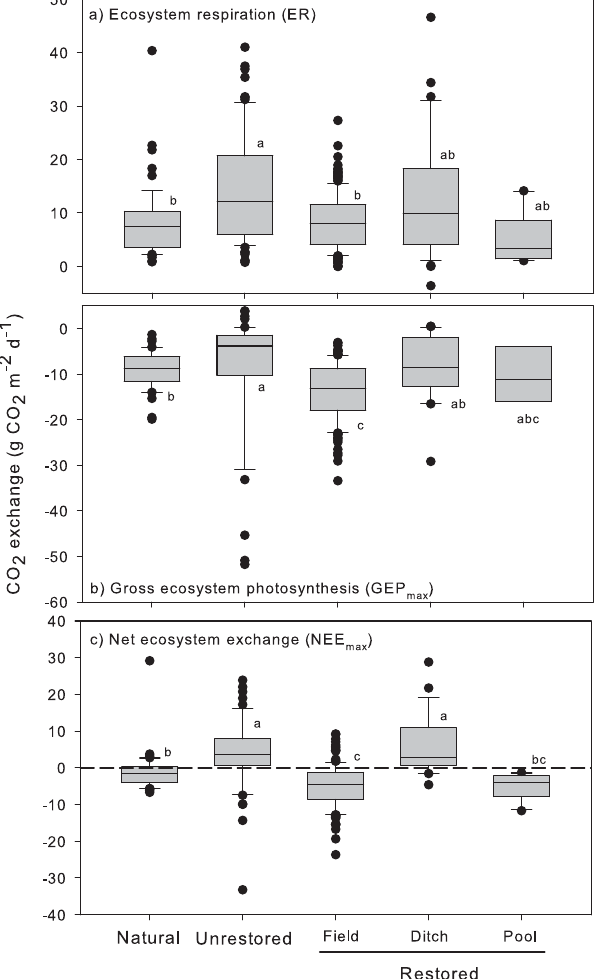
Fig. 2. Ecosystem respiration (a) , gross ecosystem photosynthesis (b) and net ecosystem exchange (c) at natural, unrestored and re- stored sites during the growing season (May–October). Values for gross ecosystem photosynthesis and net ecosystem exchange repre- sent only those measured when photon flux density of photosynthet- ically active radiation was greater than 1000µmolm − 2 s − 1 . Box plots indicate 10th and 90th percentile with bars, 25th and 75th per- centiles with top and bottom of box and median with center line. Medians are significantly different from each other if they share no letters in common. Letters should only be compared within one